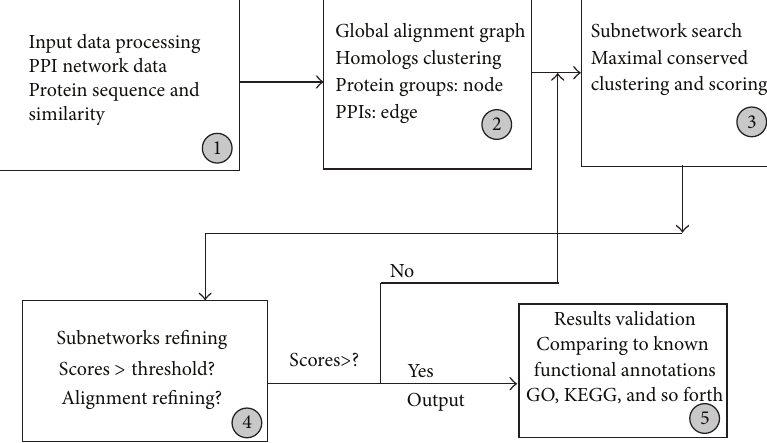
Figure 5: HopeMap network alignment in five